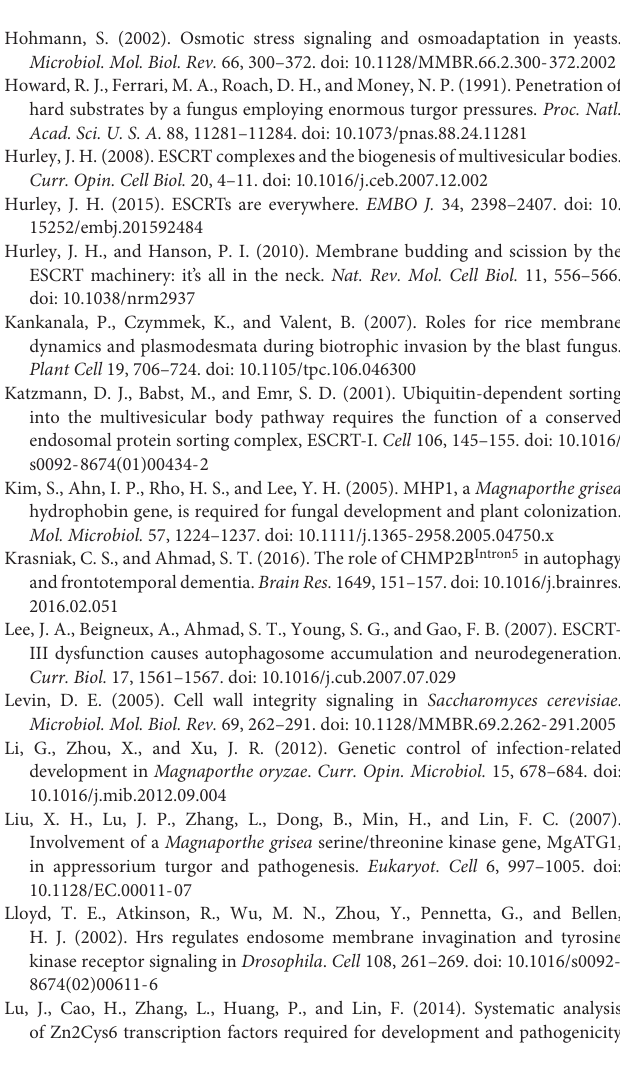
Supplementary Figure 1 | (A) Multiple sequence alignment of MoIst1 homolog proteins using CLC Main Workbench. (B) Successful replacement was verified by PCR. (C) The copy number was determined by quantitative real-time PCR (qPCR). (D) Conidial germination rates of WT, (cid:49) Moist1, and Moist1C at 4 h. The standard deviation is represented by error bars. Tukey’s test was used to test significant differences: ∗∗ P < 0.01, ∗ P <